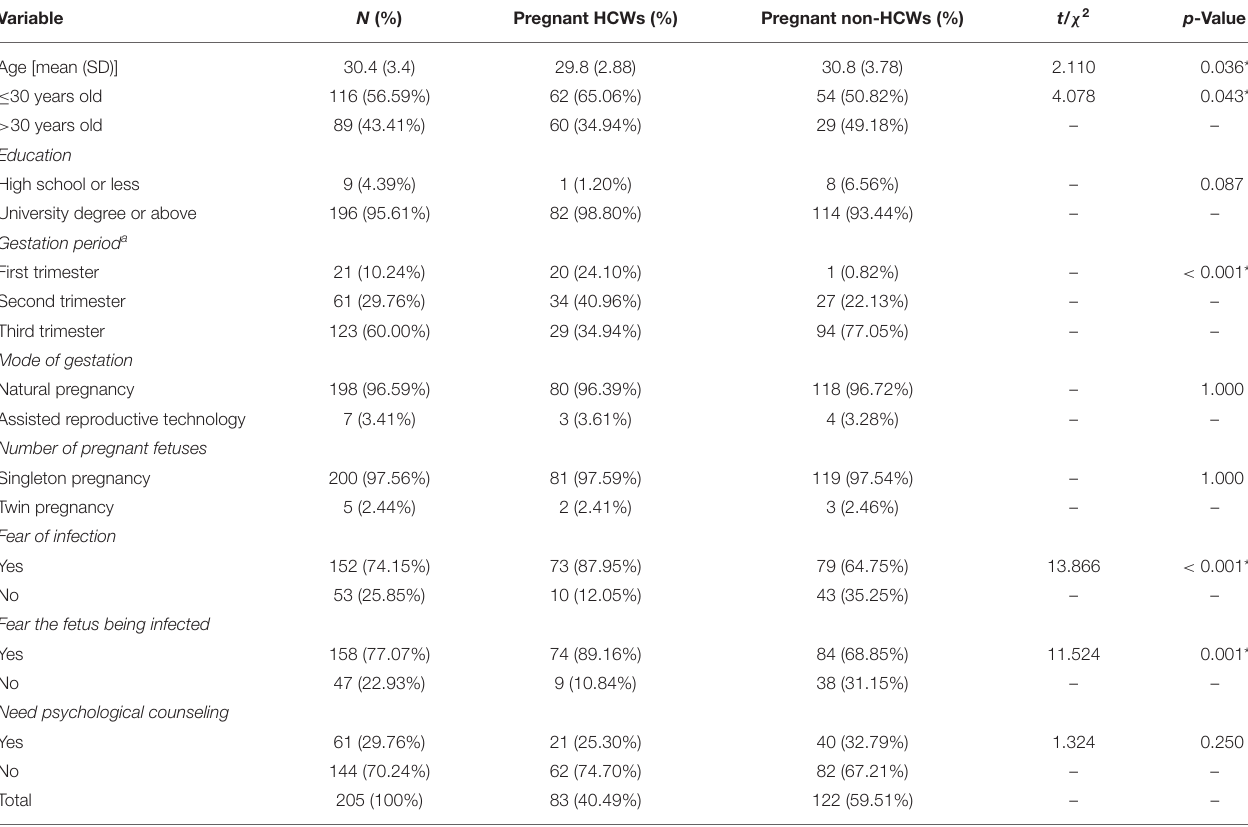
TABLE 1 | Sociodemography between pregnant HCWs and pregnant non-HCWs.